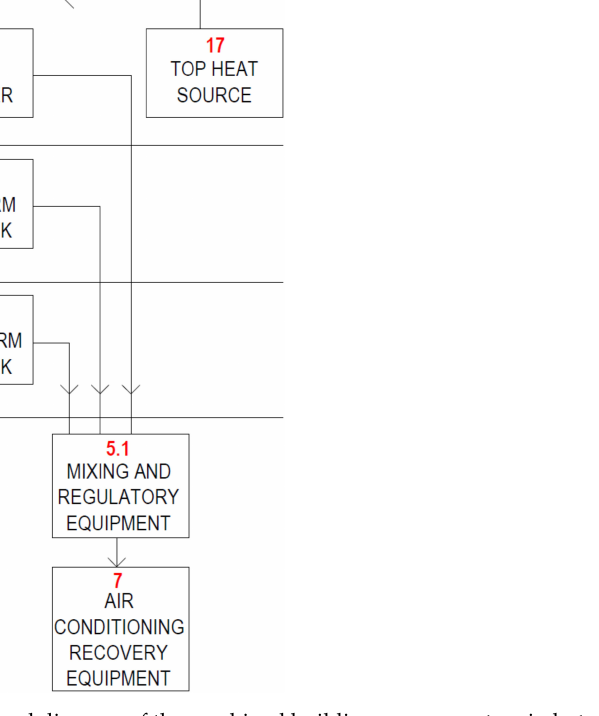
Figure 10. Functional diagram of the combined building-energy system in hot-air heating mode